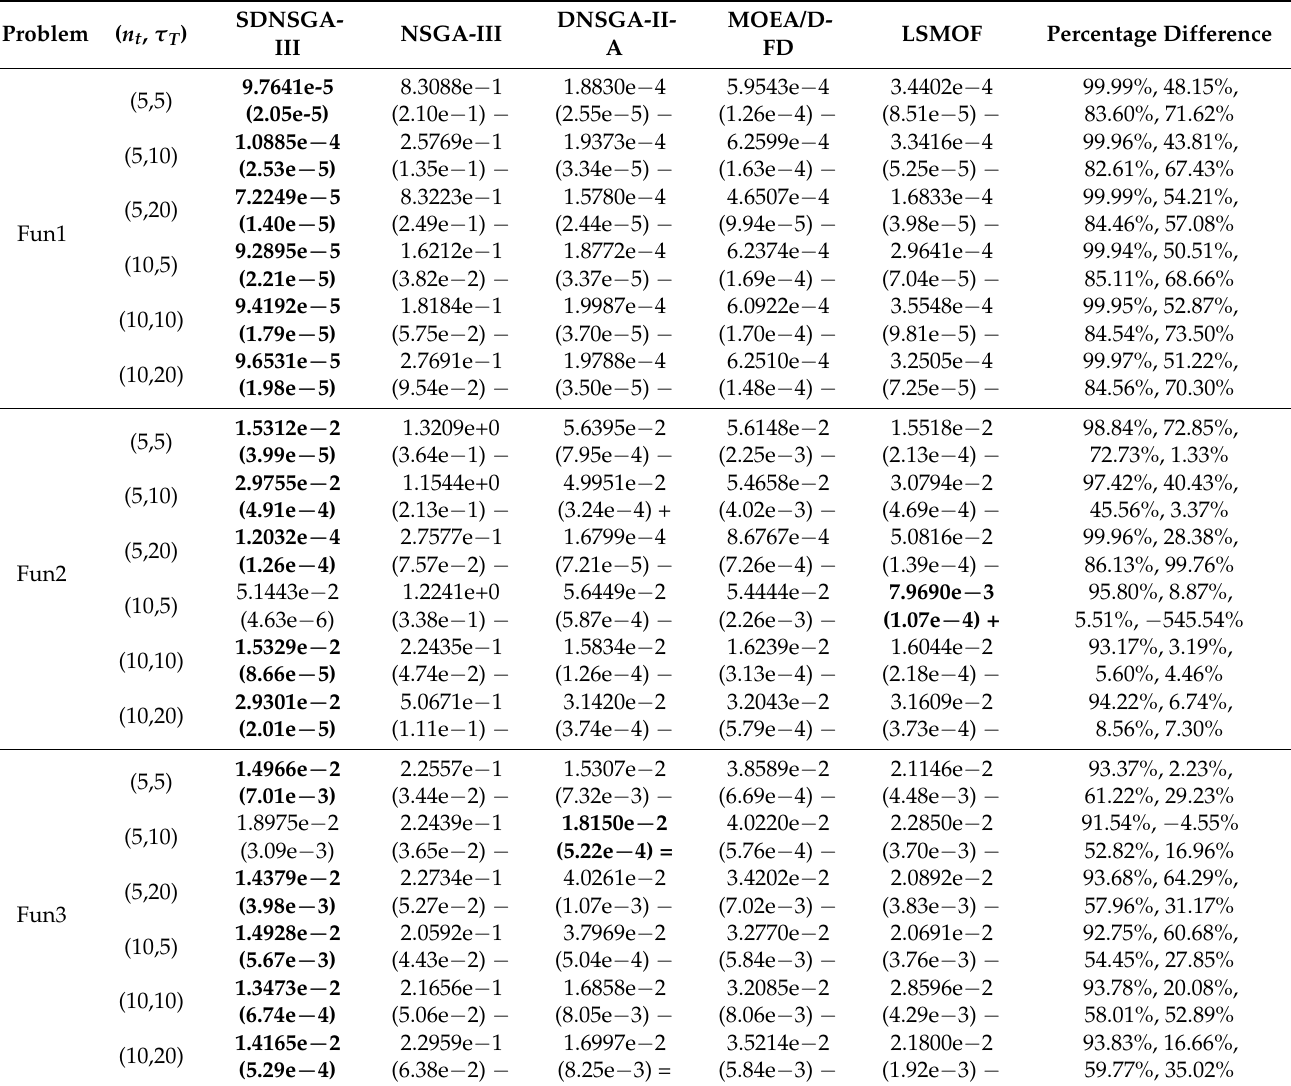
Table A1. The MGD values and standard deviations obtained by five